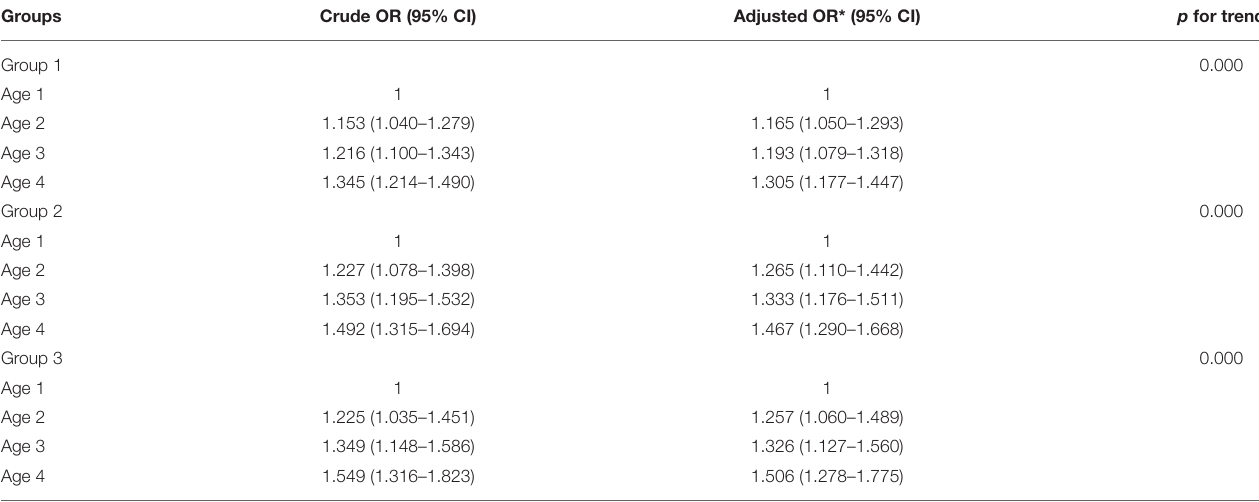
TABLE 3 | Multiple logistic analysis of risk factors of diagnostic delays in human brucellosis. Groups